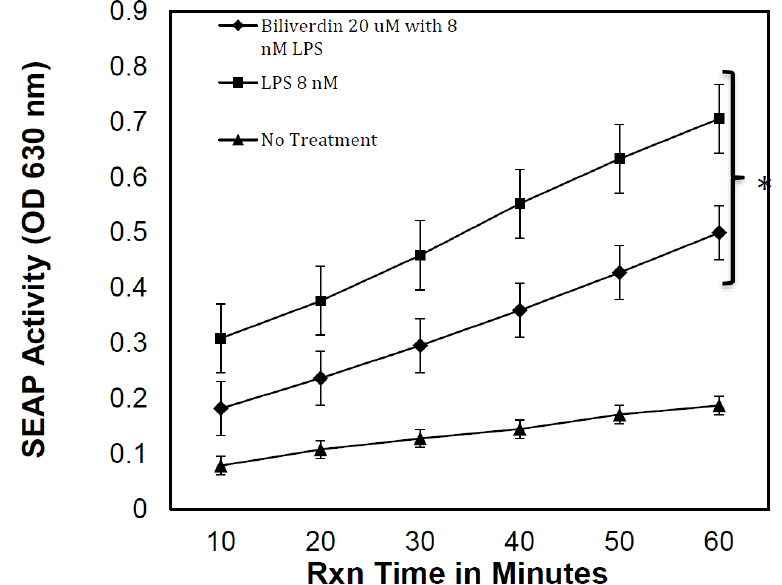
Figure 6. Kinetic evaluation of SEAP activity in supernatants derived from LPS-treated HEK-Blue hTLR4 cells. Cells at an initial density of 1 x 10 5 / well were cultured overnight with 8 η M LPS (squares), 8 η M LPS plus 20 uM Bv (diamonds), or media alone (triangles). Since it had been shown in Figure 5 that Bv alone was non-stimulatory and Bv inhibition of baseline was insignificant, Bv alone treatment was not reiterated here. The 8 η M concentration of LPS used here corresponds to 0.8 µ g / mL based upon a molecular weight of 100,000 (Sigma). A 60 min SEAP time course of substrate conversion was evaluated to show SEAP velocities over time (Slope LPS + Bv = 0.0065, R 2 = 0.997; Slope LPS = 0.0085, R 2 = 0.999; No Treatment Slope = 0.0021, R 2 = 0.989). ANOVA measurement of significance between LPS and LPS + Bv is designated by an asterisk (*; where p < 0.05).